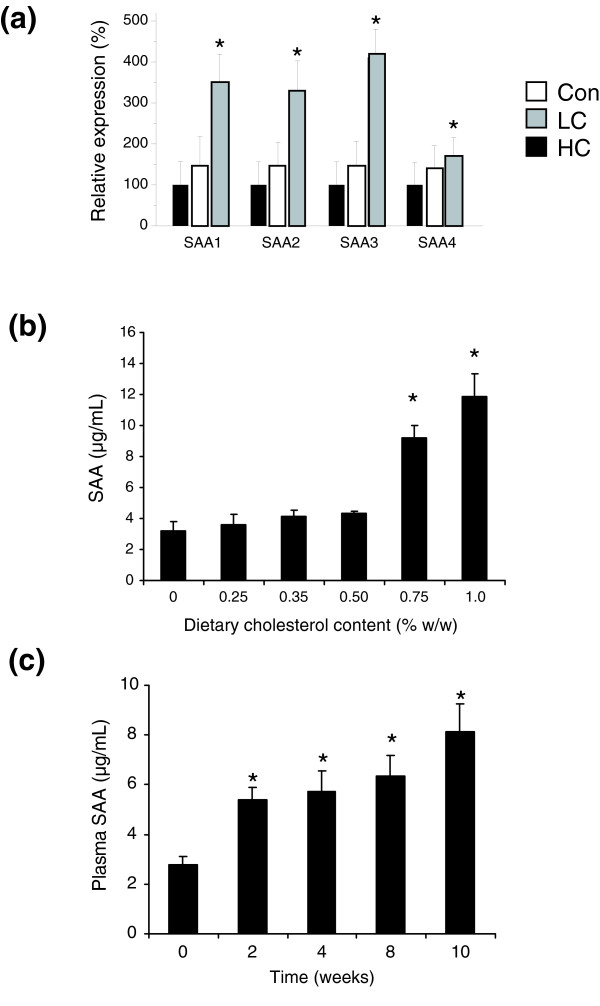
Expression of SAA genes. (a) All four isotype genes were dose-dependently increased with increasing dietary cholesterol exposure. *Significant compared to Con, P < 0.01. (b) Plasma SAA levels in response to increasing doses of dietary cholesterol. Female E3L animals (n ≥ 7/condition) were fed the Con diet supplemented with increasing concentrations of cholesterol for 10 weeks. *P < 0.05 versus 0% w/w cholesterol control group. (c) Plasma SAA levels in the HC diet (1% w/w cholesterol) fed female E3L animals (n = 8) over time. *P < 0.05 versus t = 0.